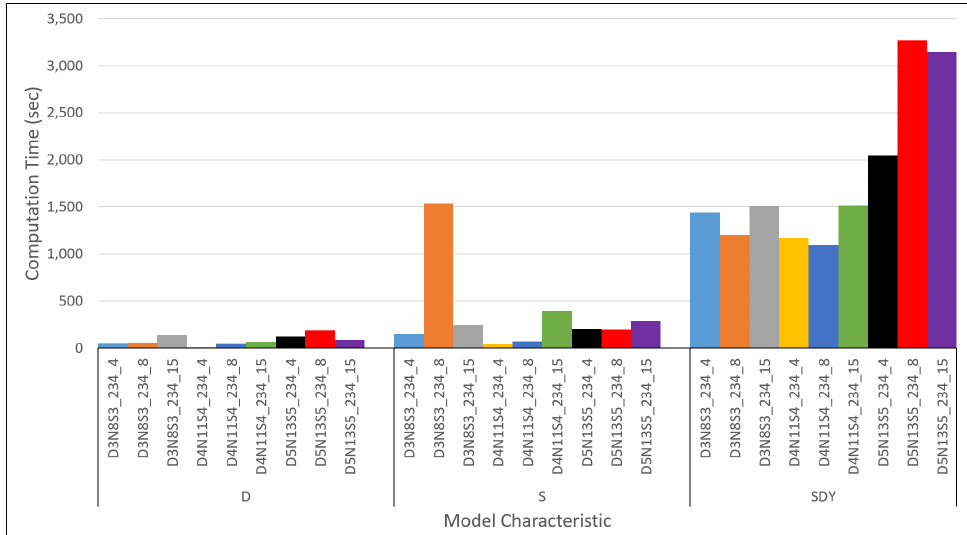
Figure A19. Computation Time for Maximum Road Capacity Setting ( 2,3,4 ) in Online and Offline Computation for all Instances grouped by Model Characteristic.